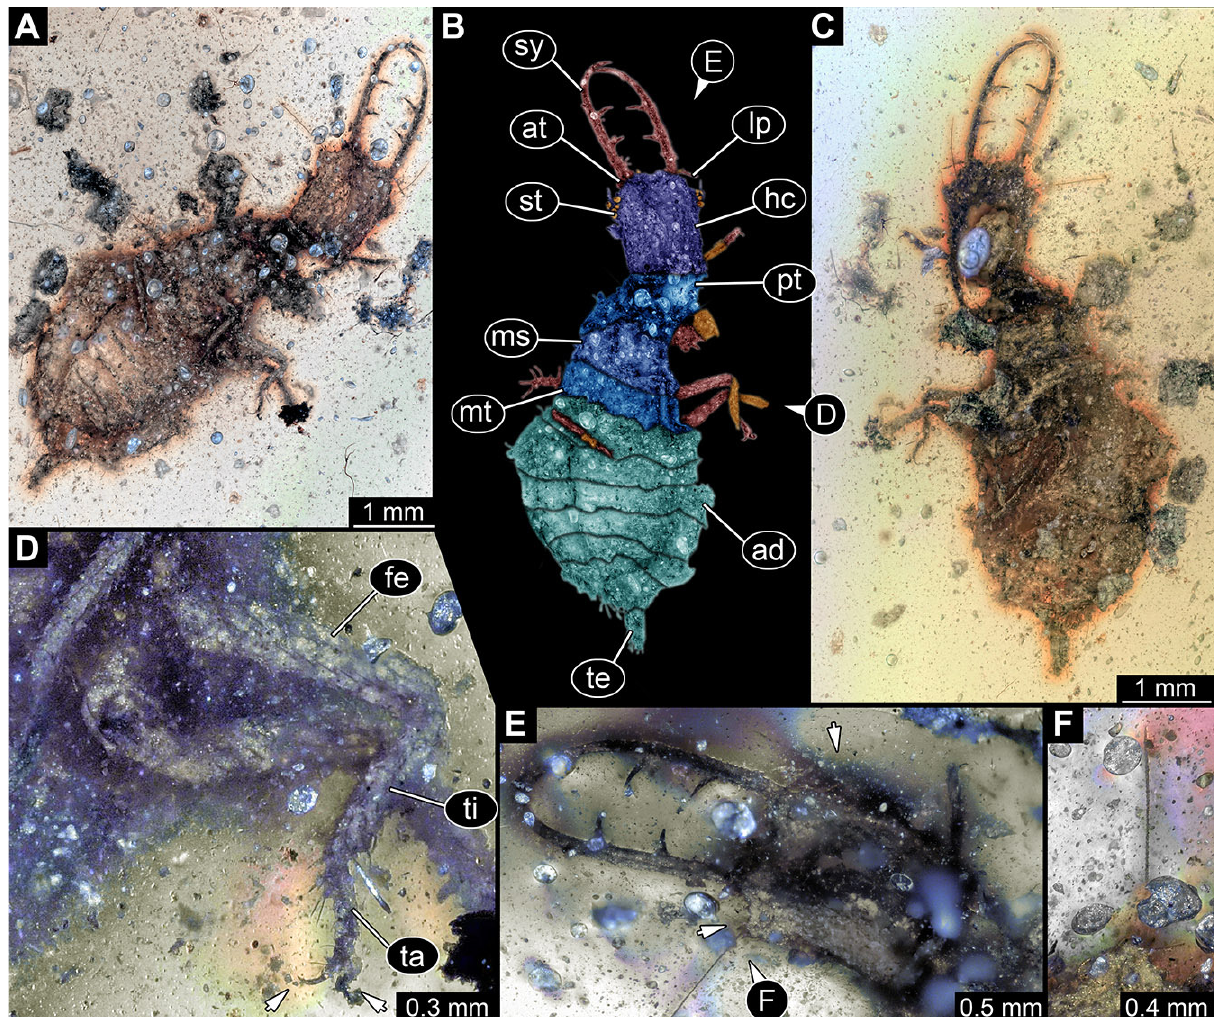
Figure 23. Fossil owllion larva, specimen 3236 (PED 0318), Cretaceous Kachin amber, Myanmar. ( A ) Overview, ventral. ( B ) Color-marked version of ( A ). ( C ) Overview, dorsal. ( D ) Close-up on locomotory appendage with claws (arrows). ( E ) Close-up on head capsule with fields of stemmata (arrows). ( F ) Close-up on antenna. Abbreviations: ad = abdomen; at = antenna; fe = femur; hc = head capsule; lp = labial palp; ms = mesothorax; mt = metathorax; pt = prothorax; st = stemmata; sy = stylet; ta = tarsus; te = trunk end; ti = tibia.